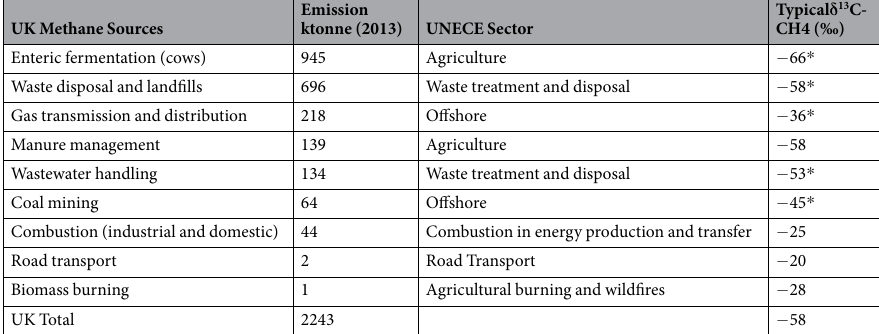
Table 1. δ 13 C signatures of UK methane sources, based on measured values 13, 18 and literature review. * Indicates values that have been revised by the study of Zazzeri 19 . 2013 NAEI emission inventories are provided without errors. The agriculture sector includes both enteric fermentation and manure; offshore category refers to emissions from fossil fuels (natural gas and coal); waste treatment sector includes both landfill sites and sewage works. The natural gas isotopic value of − 36‰ has been attributed to the “offshore” sector, as no coal mines are located within the London area. Errors of measured isotopic values are within ±